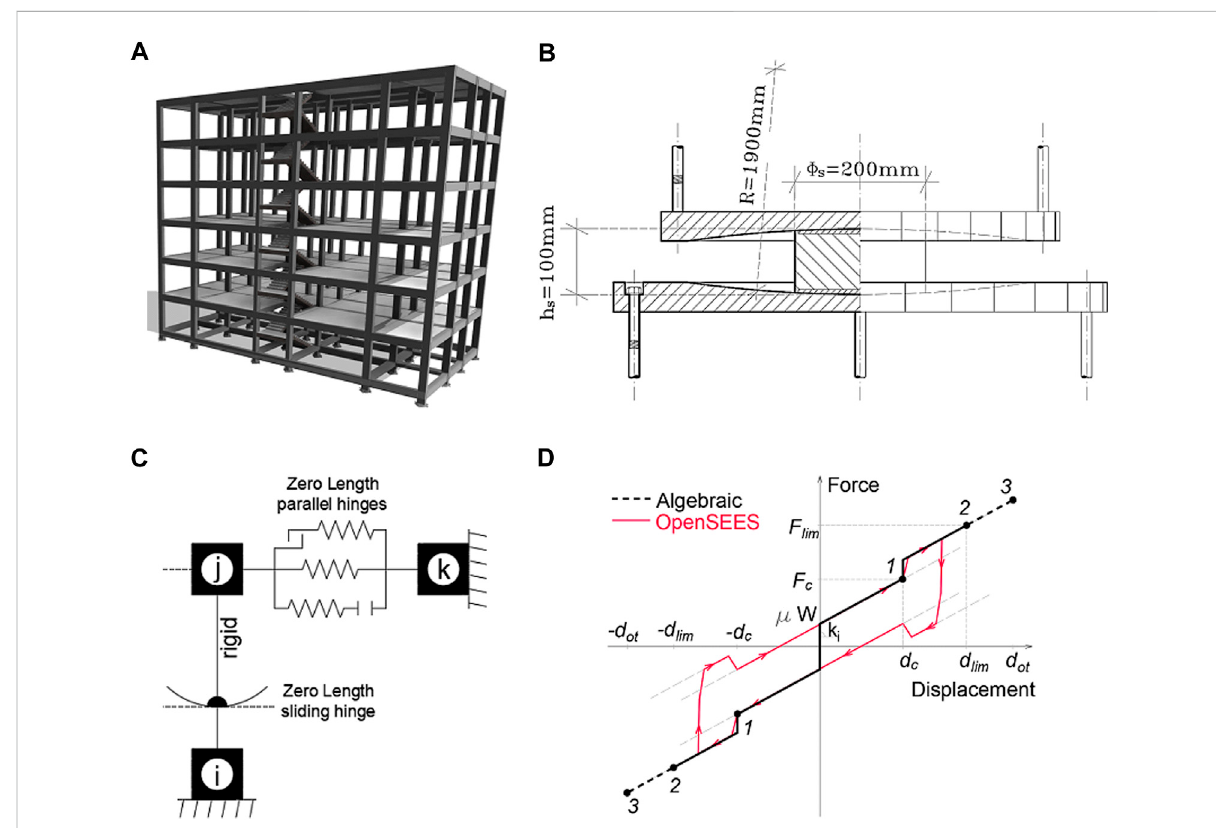
FIGURE 9 (A,B) Proposedcasestudystructure (A) andDCCSSisolator (B) . (C) Representation oftheisolatornumericalmodel. (D) Sloping dogboneshape constitutive